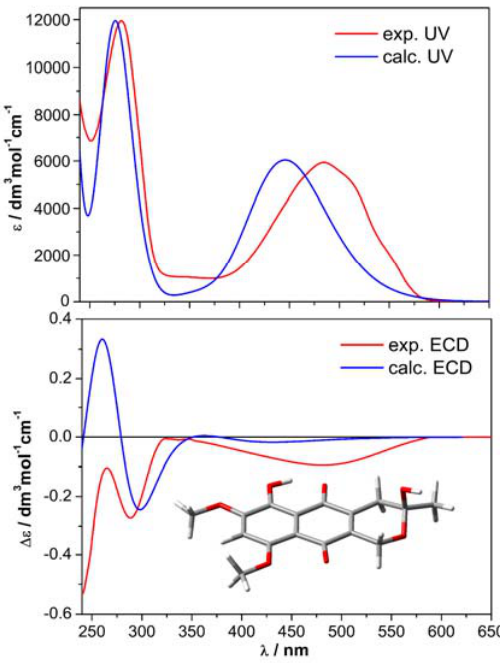
Figure 3. Comparison of experimental and calculated UV/ECD spectra for ( R ) ‐ 1 . Measurement run on 0.25 mM solution in MeCN. Calculations run at CAM ‐ B3LYP/def2 ‐ TZVP// ω B97X ‐ D/6 ‐ 311+G(d,p) level including a PCM solvent model for MeCN; Boltzmann averaged over three conformers (the most stable is shown in the inset); plotted as sum of Gaussian function with 0.5 eV exponential band ‐ width, red ‐ shifted by 21 nm and scaled by a factor 9.835.